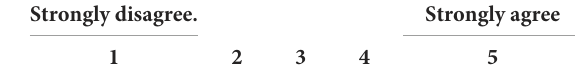
TABLE 2 The system usability scale.